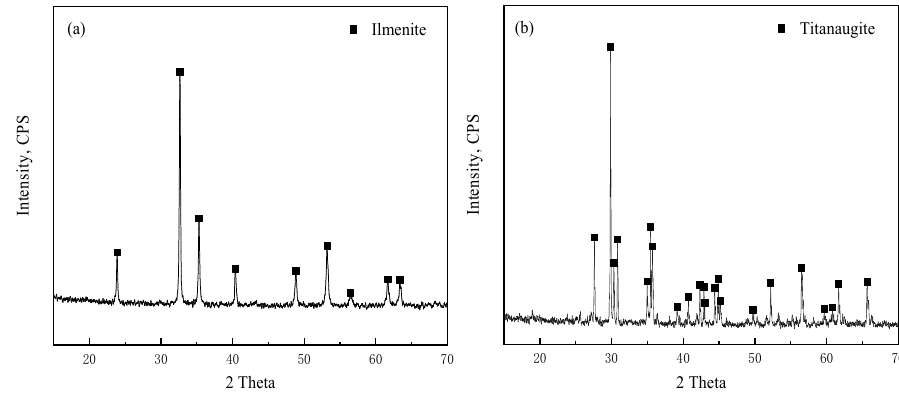
Figure 2. X-ray diffraction spectra of ( a ) ilmenite and (b ) titanaugite.